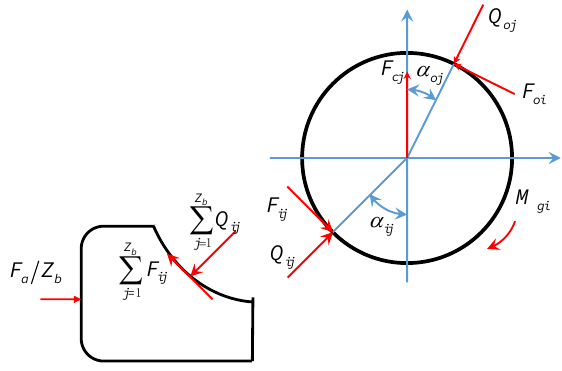
Figure 4. Ball loading at angular position ψ j .